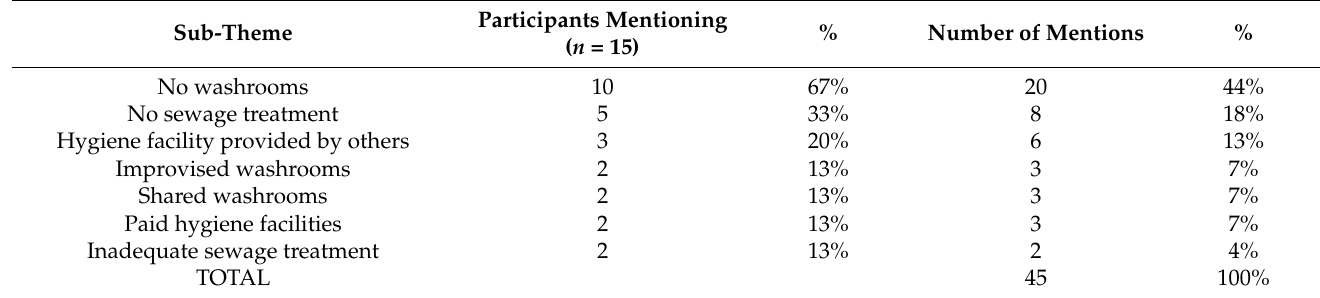
Table 9. Sanitation and hygiene services in assisted communities according to CSOs.